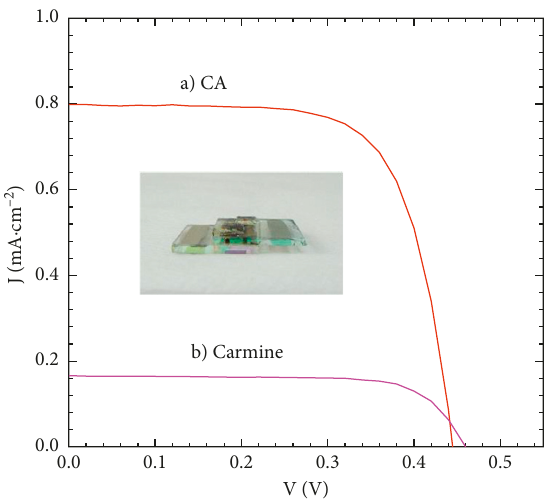
Figure 8: I-V curves of (a) CA and (b) carmine DSSCs.